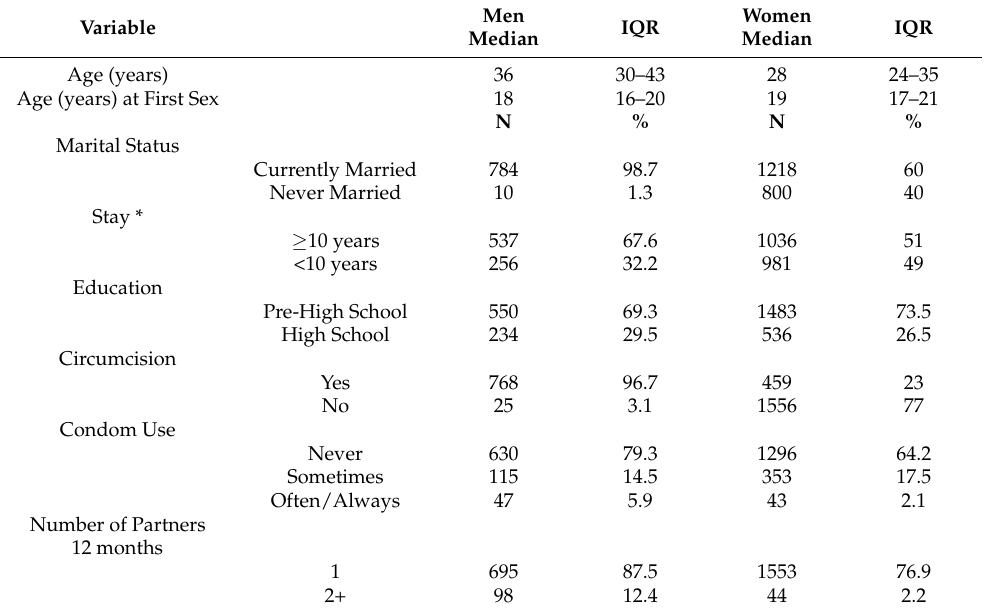
Table 1. Demographic characteristics of men ( n = 794) and women ( n = 2019) in Moshi, Tanzania, 2002–2003.